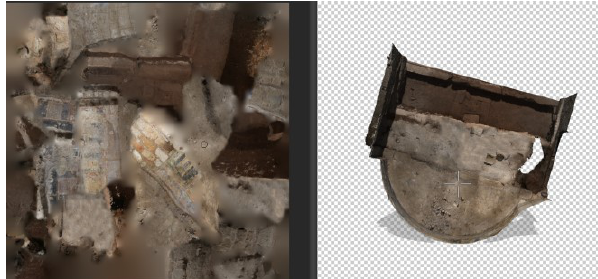
Figure 8. Real-time editing of the textured model in Adobe Photoshop CC .